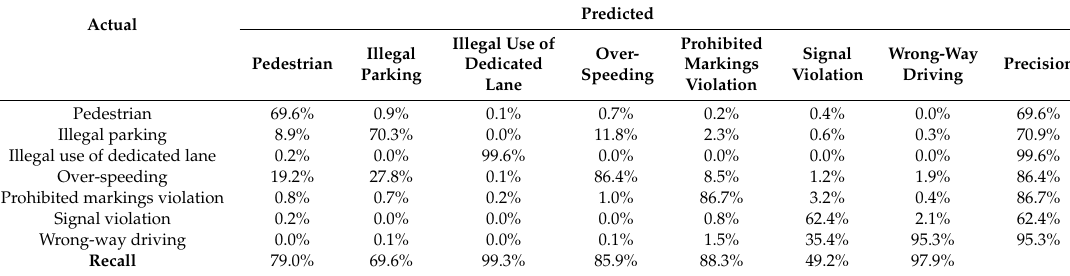
Table 4. Confusion matrix for Decision Tree (DT) model.